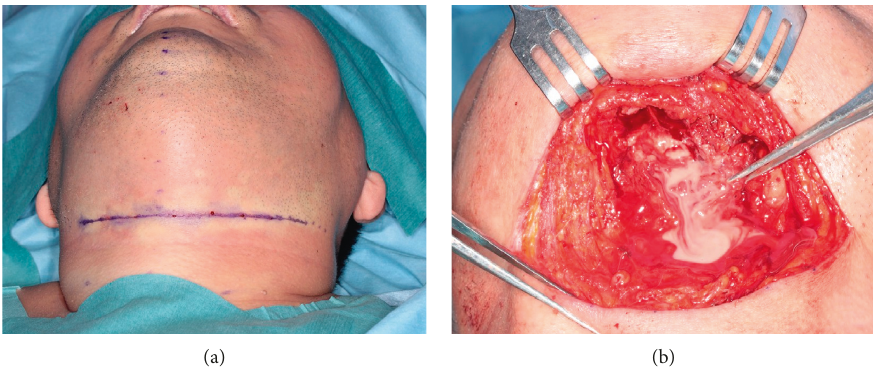
Figure 5: Intraoperative findings. The wound was opened under general anesthesia. Extensive colliquative necrosis and malodorous drainage were noted in muscle tissue. Debridement of the necrotic tissue was carried out, and the wound was left